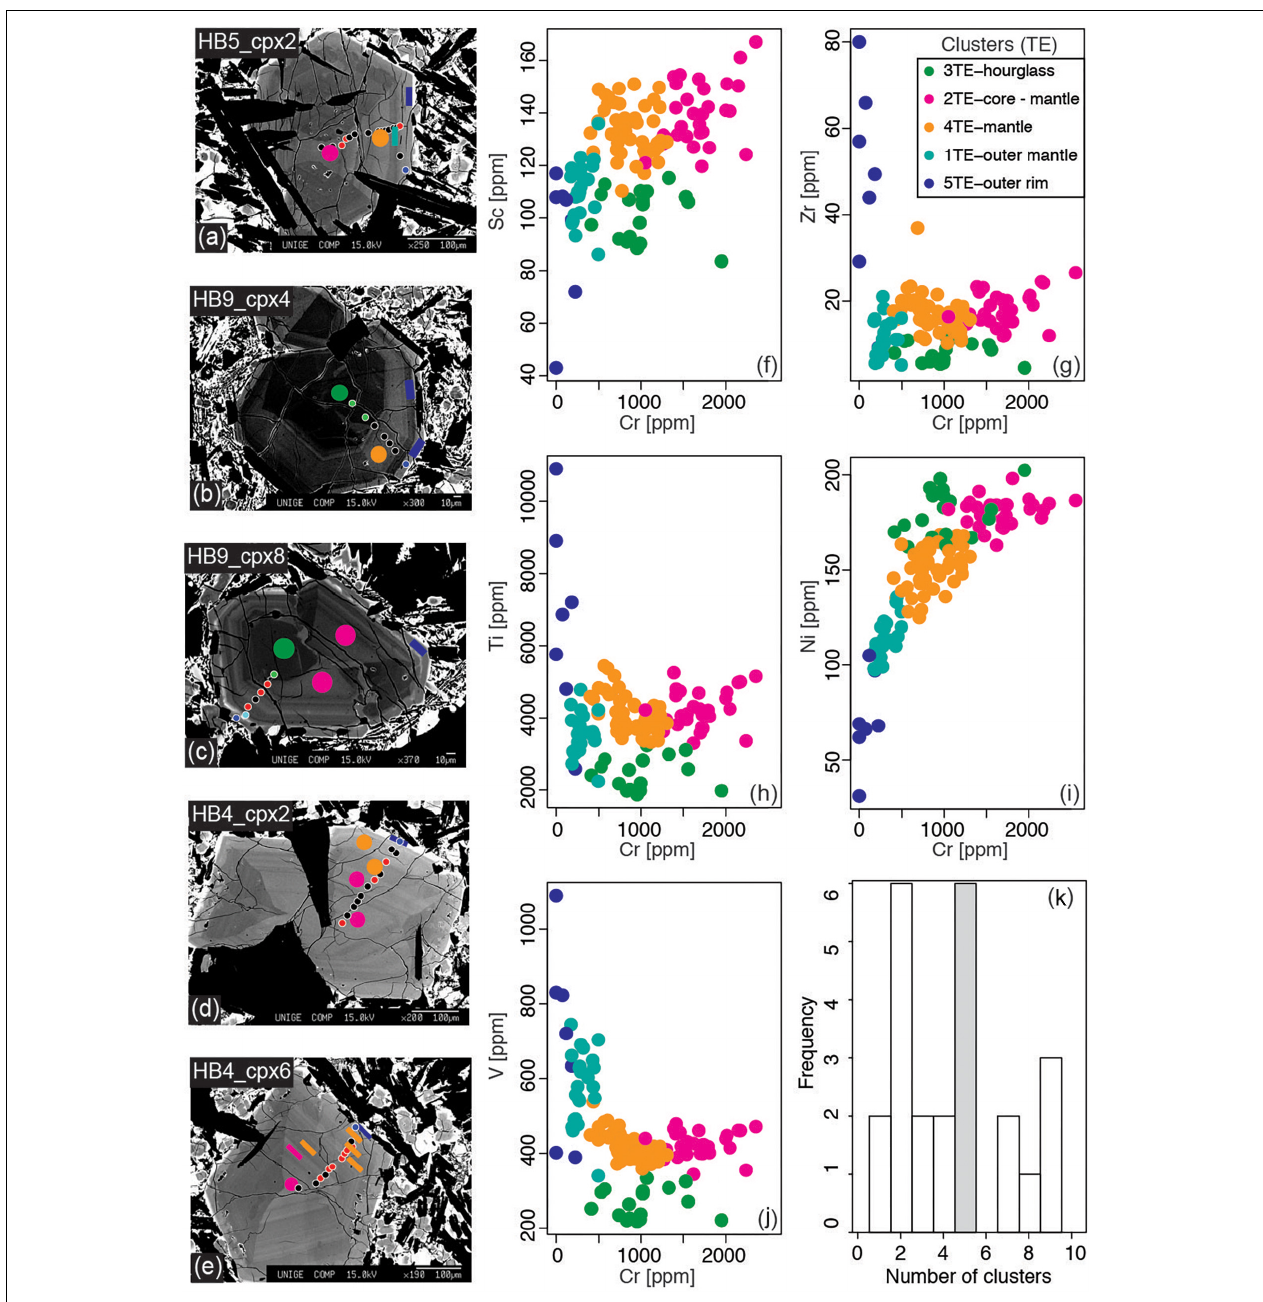
FIGURE 7 | Trace element analyses. (a–e) SEM Back scattered images of some of the cpx crystals selected for trace element analyses. Circles and rectangles provide the location of the spot and their color corresponds to the cluster assigned based on trace element content. Smaller circles are colored according to the cluster assigned applying HC to major elements. (f–j) Harker diagrams for all collected spot analyses with colors corresponding to the clusters assigned on the base of trace elements. (k) Histogram showing the result of the number of clusters determined using 24 different metrics. The gray shading highlights the selected number of